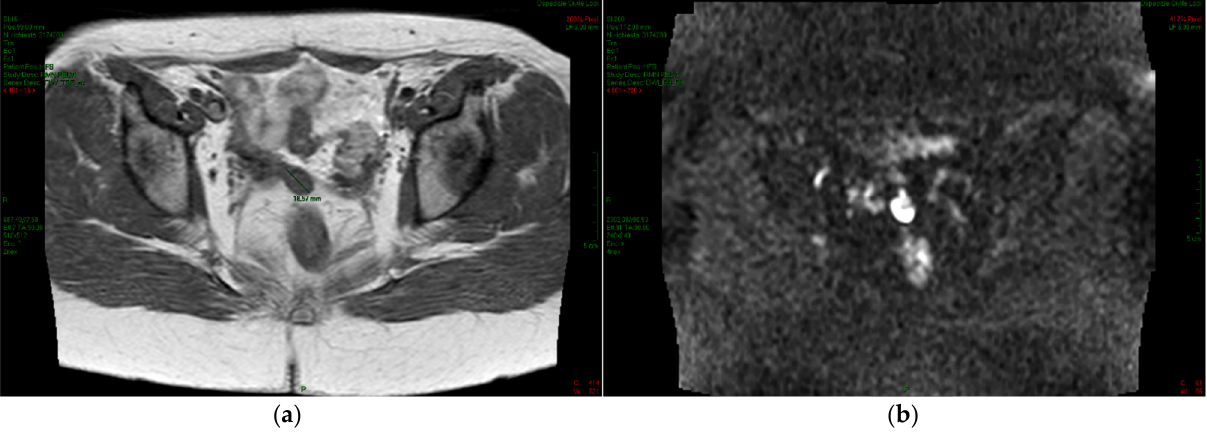
Figure 1. Magnetic resonance. A solid mass is identified as an 18 mm nodule located above the vaginal cuff with intermediate signal intensity on T1 TSE-weighted axial imaging ( a ) and with high signal intensity on diffusion-weighted MRI ( b ), suggesting the presence of a highly cellular lesion.